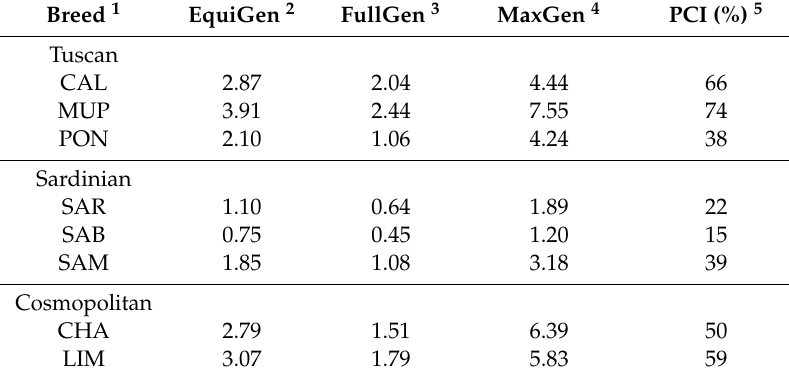
Table 2. Pedigree completeness